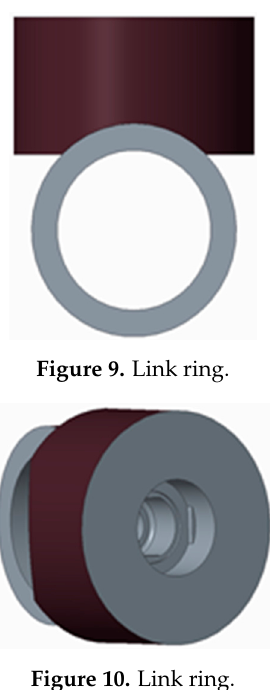
Figure 10. Link ring.